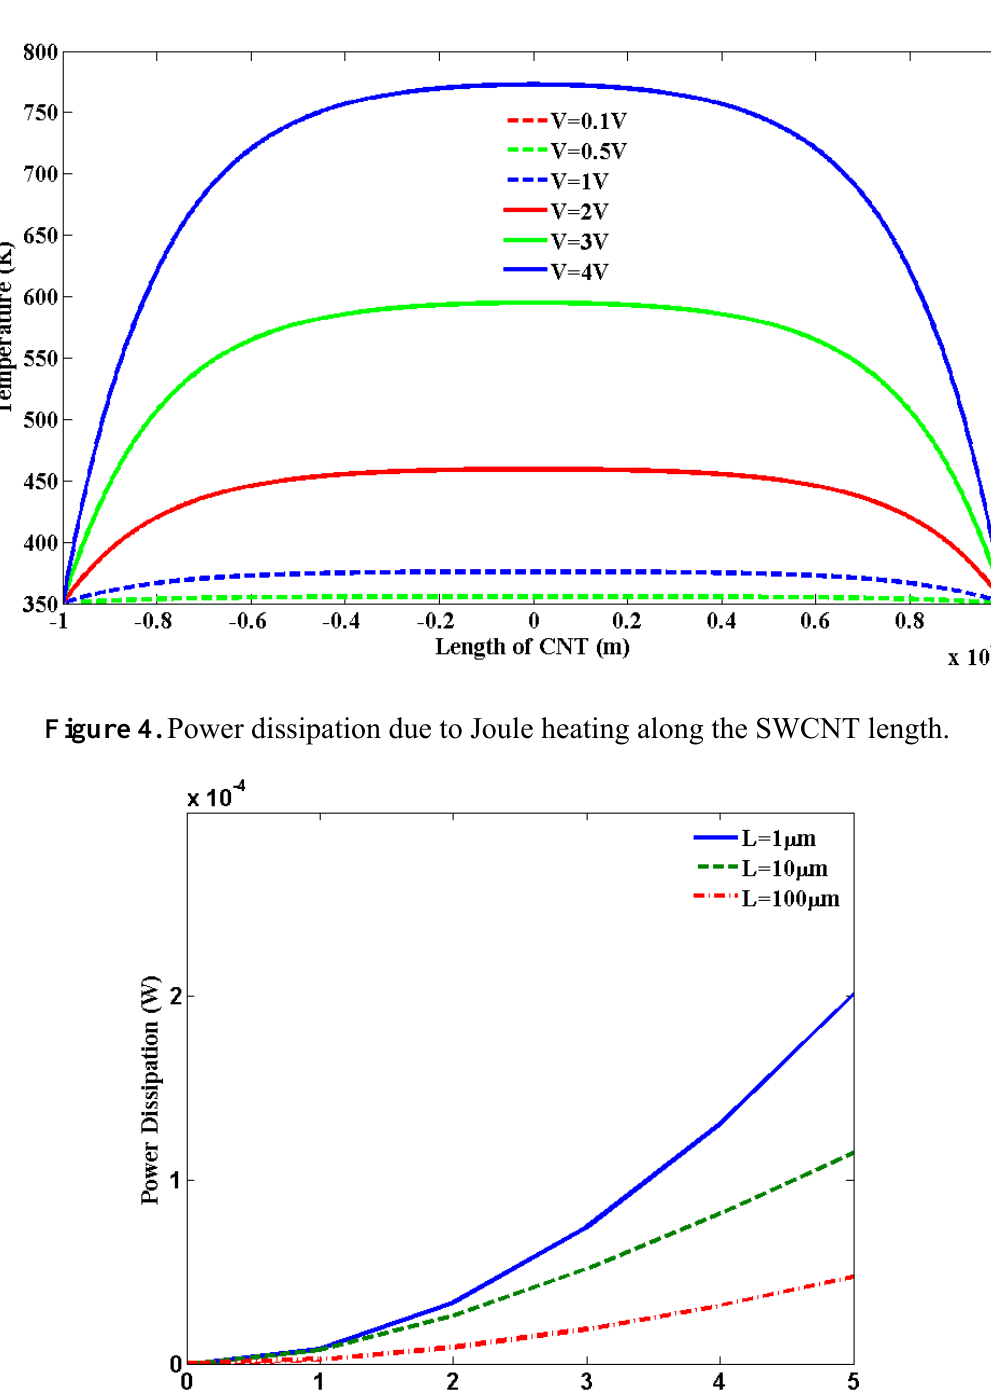
Figure 3. Temperature profile of SWCNT of 2 µm length.